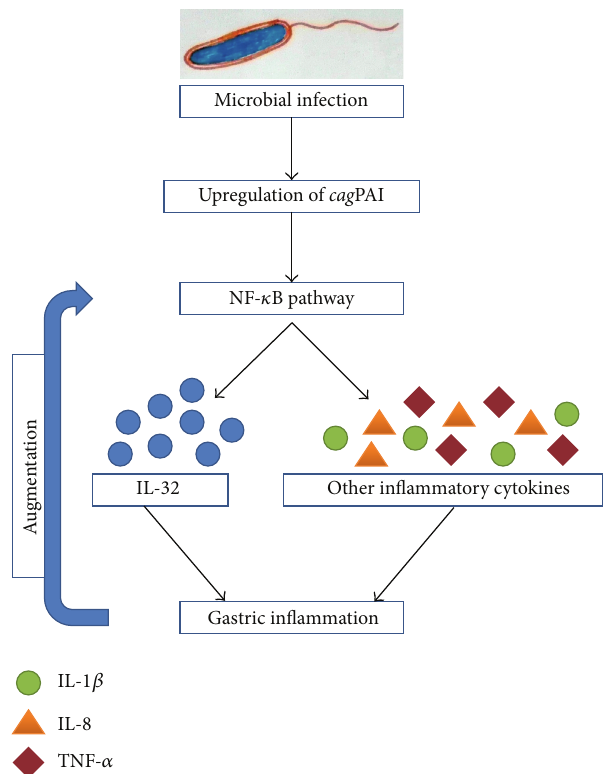
Figure 3: Microbial infection induced expression of IL-32 results in gastric inflammation. Microbial infection ( H. pylori ) leads to the upregulation of cag PAI cluster of genes which through the activation of NF- 𝜅 B pathway results in the synthesis of IL-32 and some other potent inflammatory cytokines (IL-1, IL-8, and TNF- 𝛼 ) thatresultsingastricinflammation.Theresultinginflammationself- augments the activation of NF- 𝜅 B pathway which further aggravates the